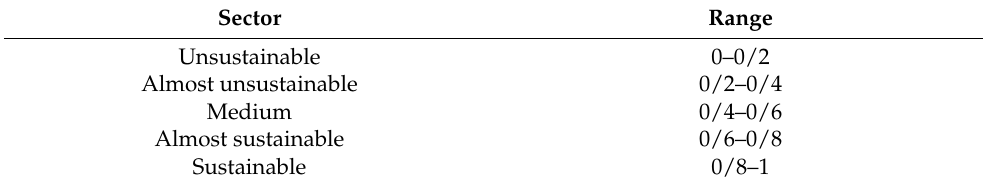
Table 4. Sustainability classification from Prescott-Allen’s perspective